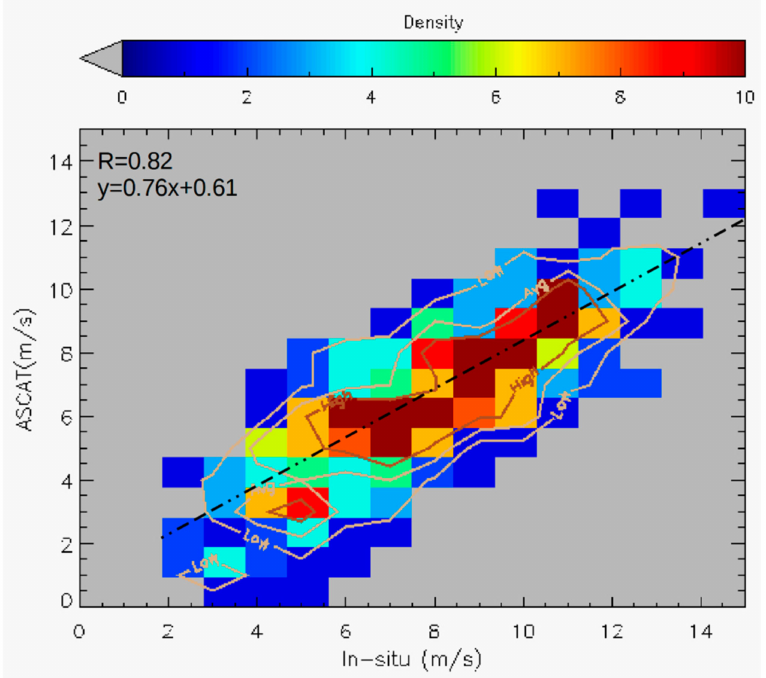
Figure 2. Density plot and regression line for Scatterometer winds with respect to in situ mea- surements winds for 2018 at the Dakhla site; the colour bar indicates the number of collocated Scatterometer